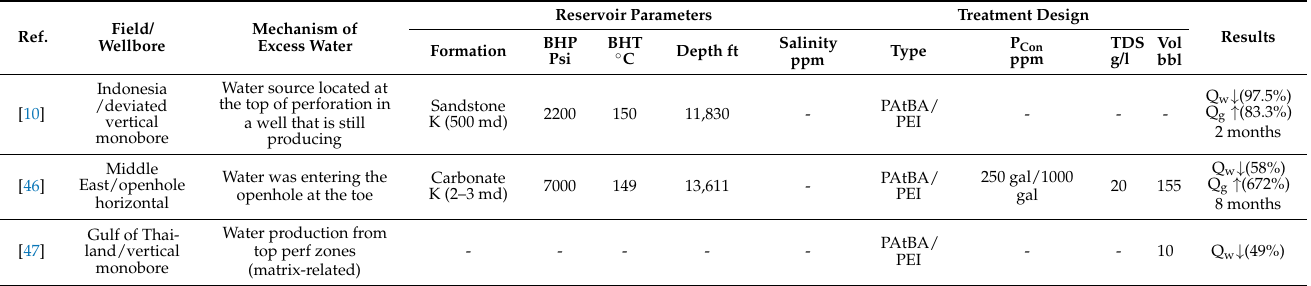
Table 5. PAtBA/PEI—water shutoff treatments in gas production wells (WSOGs). Ref.